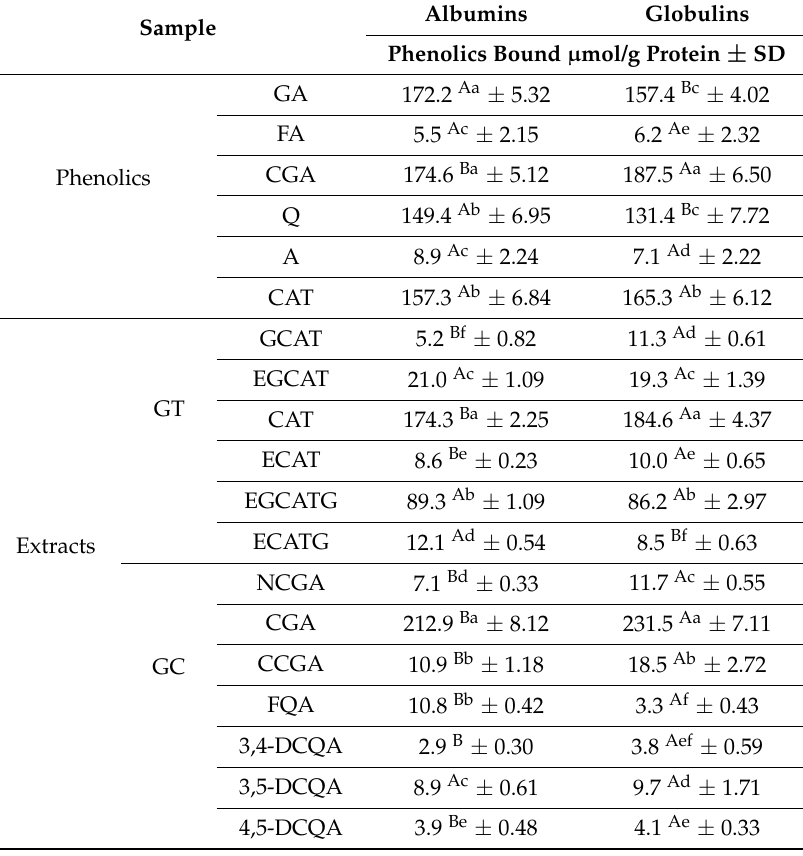
Table 1. Binding capacity of proteins for phenolic